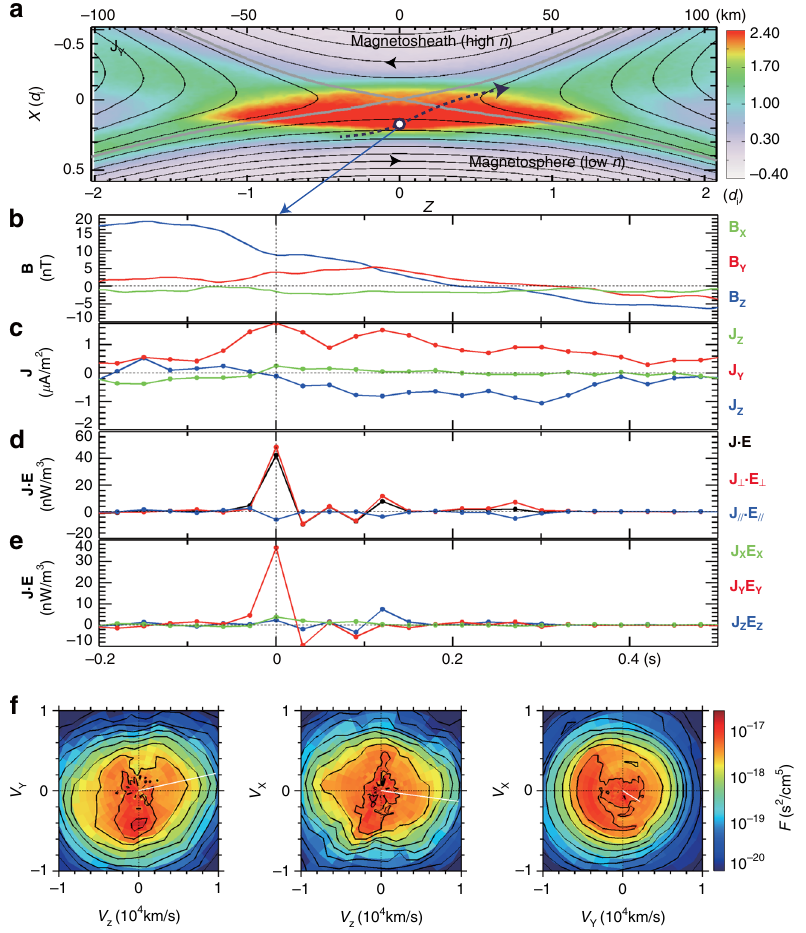
Fig. 3 MMS measurements of the electron diffusion region with negligible guide fi eld. Energy deposition to electrons peaks at the electron diffusion region. a Path of MMS through the electron diffusion region illustrated on the out-of-plane current density ( J Y ) contours from a 2D PIC simulation. b The magnetic fi eld components. c The components of the current density. d The value of J ∙ E ~ J ⊥ ∙ E ⊥ ~ j ∙ E ⊥ spikes up when the spacecraft MMS2 encounters the e ⊥ electron diffusion region. The encounter at the center of the electron diffusion region occurs around the time of t = 0. e The J ∙ E is dominantly contributed by J Y E Y ~ j e Y E Y . f Electron velocity distribution function in three orthogonal velocity planes. The distribution is from the peak J ∙ E (time marked by a vertical dotted line in b – e ; motion of the MMS satellites is marked by a black open circle in a ). The data are plotted in the frame of the X-line. The direction of the electron fl ow vector from the velocity distributions shown in f is consistent with that of the electron fl ow vector measured in MRX (Figs. 1c,